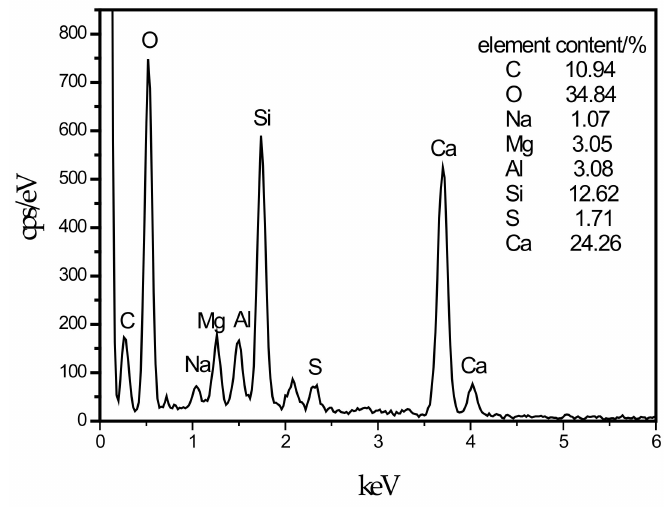
Figure 6. EDS energy spectrum of